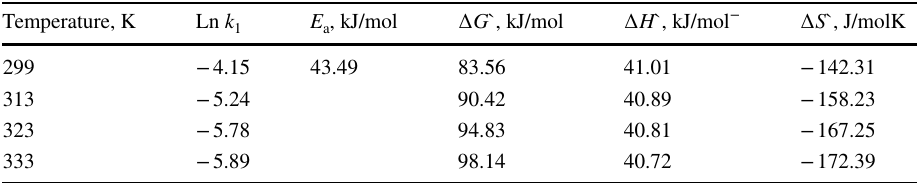
Table 5 Thermodynamic data of BB9 oxidation via CS-M(2– 1)-based Fenton system